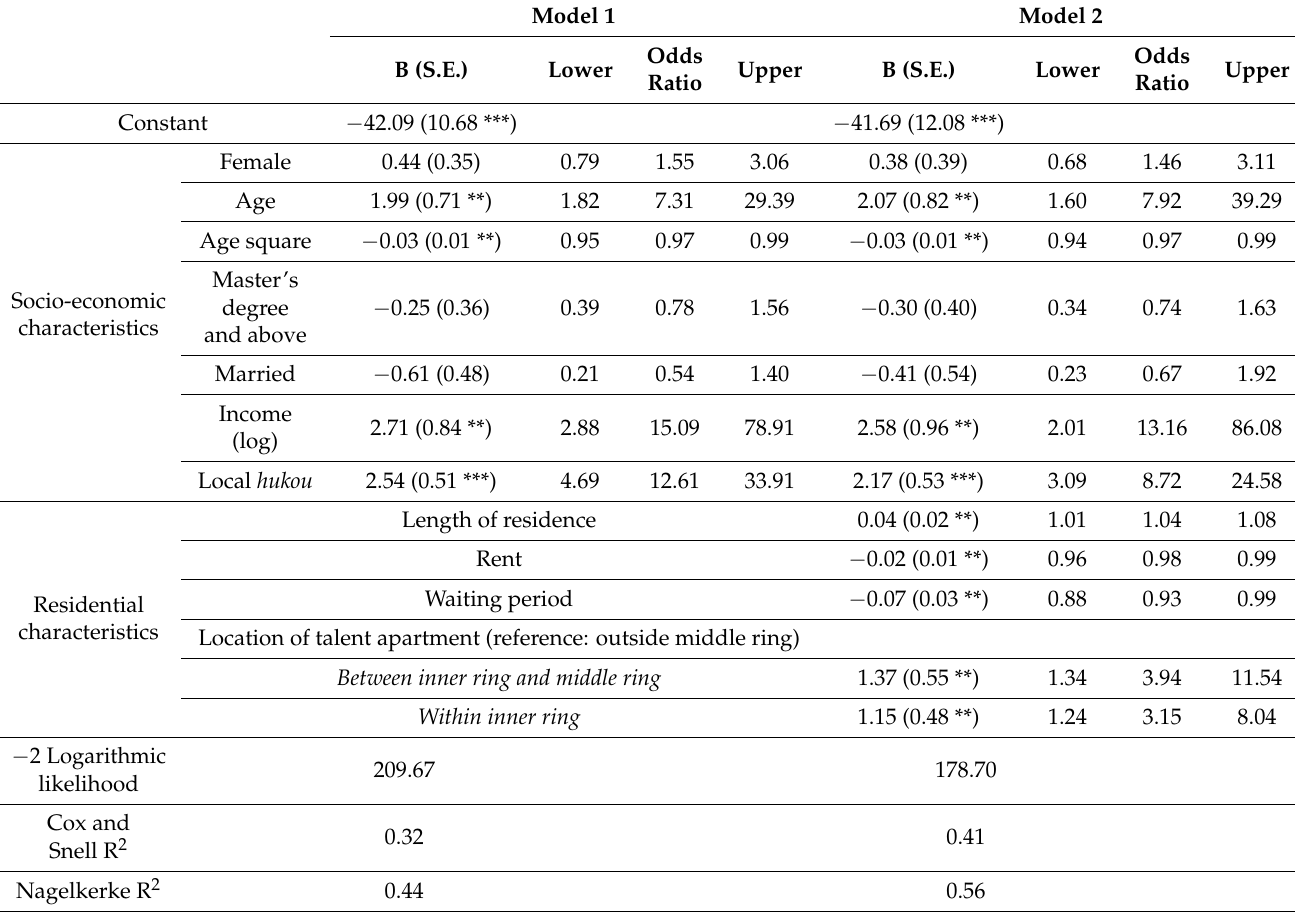
Table 4. Effects of socio-economic and residential characteristics. Model